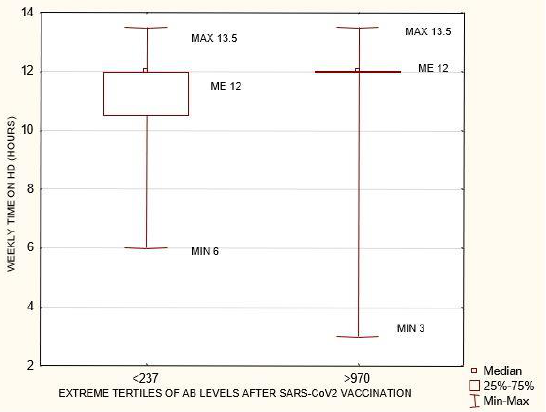
Figure 5. Statistically significant differences in weekly time on HD between the extreme terciles of AB levels after SARS-CoV-2 vaccination <237 AU/mL and >970 AU/mL p = 0.018. Mann – Whitney U test. AB: antibody.